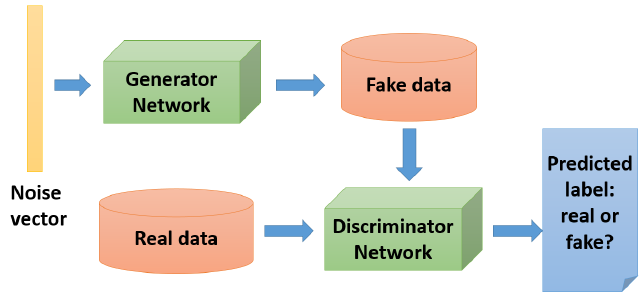
Figure 2. Generative adversarial